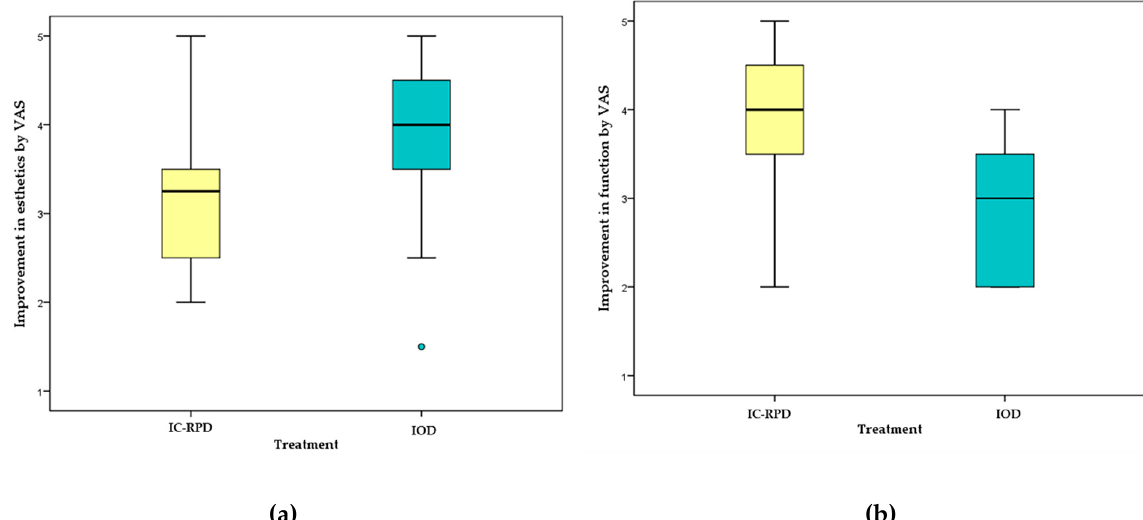
Figure 4. Comparison in satisfaction rate (esthetic and function) by VAS before vs. after prosthetic treatment. The Wil- coxon-Signed Ranks test showed there were significant differences before and after treatment in both esthetics and func- tion regardless of the treatment modalities ( p < 0.05). Asterisk (*) indicated statistical differences ( p < 0.001).